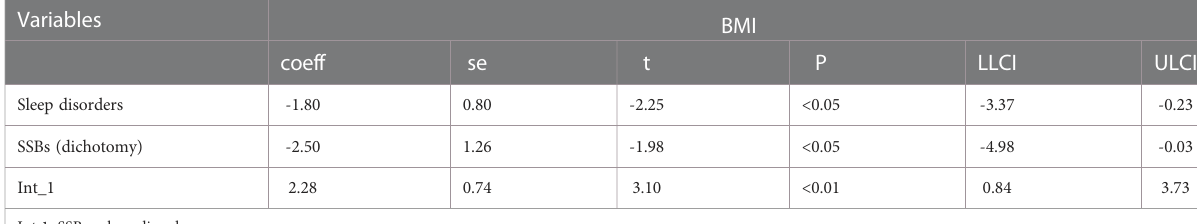
TABLE 5 The moderation analysis between SSBs, sleep disorders and BMI. Variables